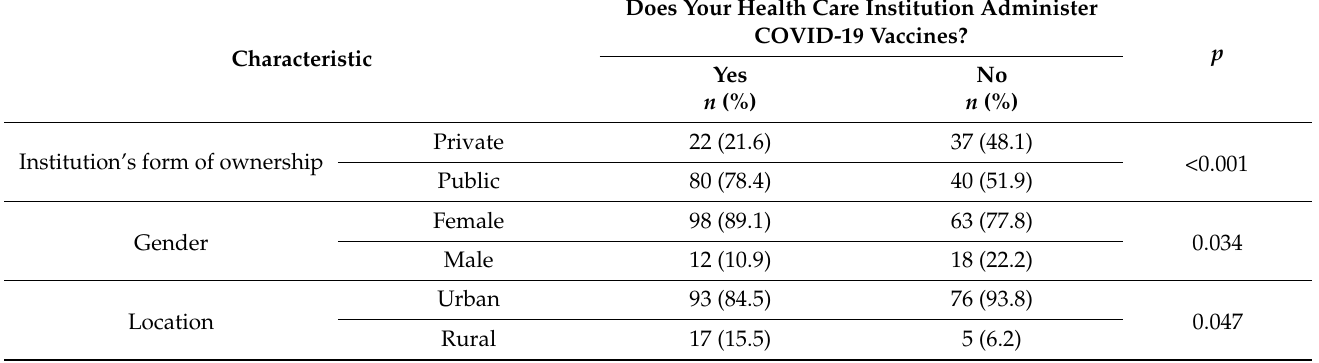
Table 8. Relationships between the sociodemographic characteristics of respondents and COVID-19 vaccine